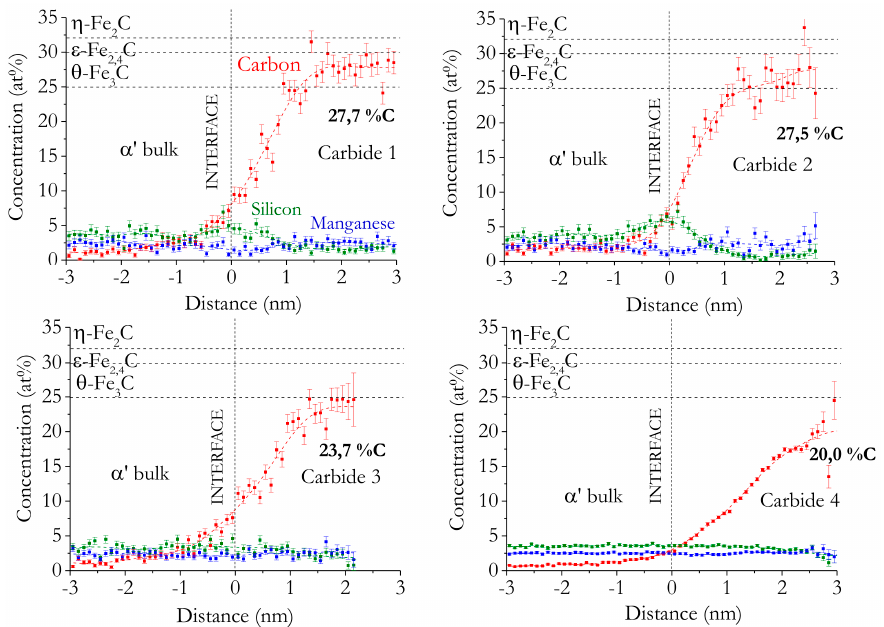
Figure 17. Proxigrams corresponding to the carbides in Figures 15 and 16 (QT200 / 200